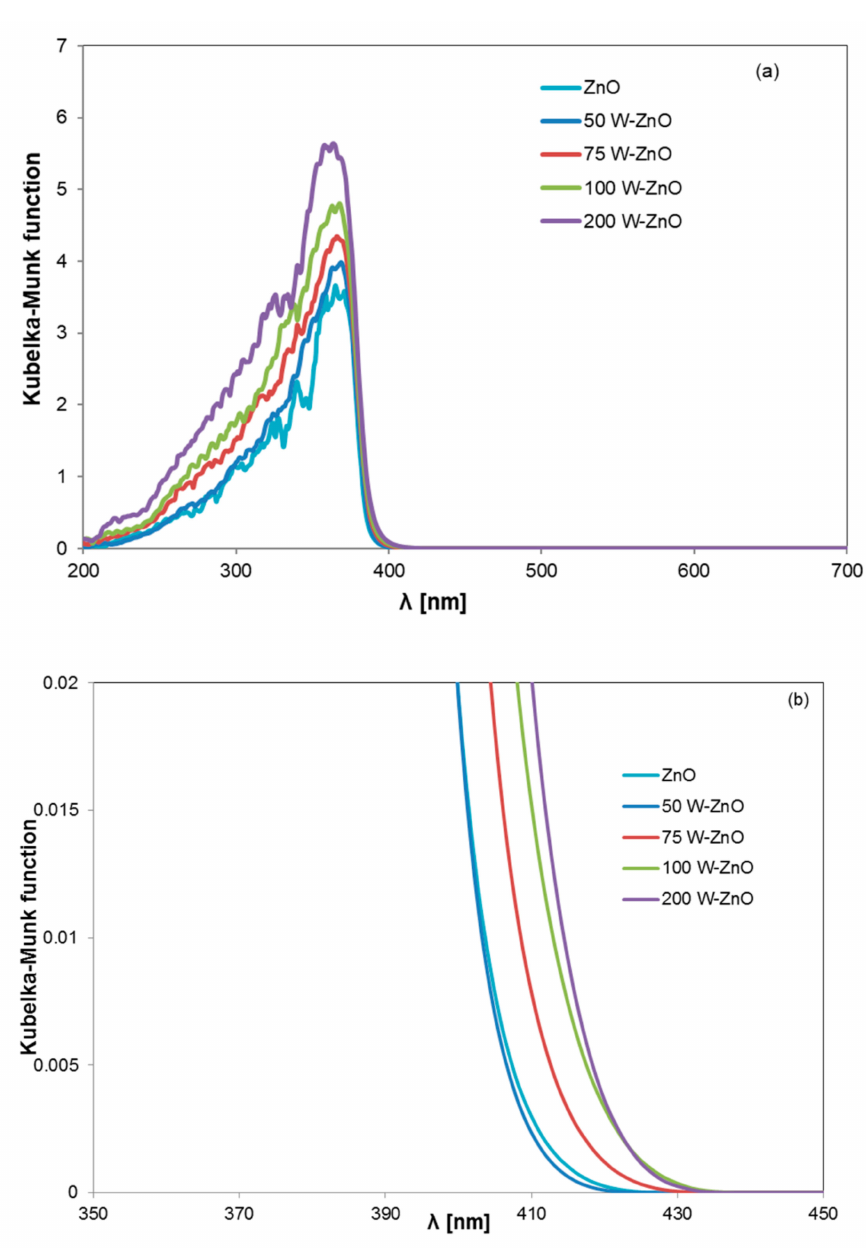
Figure 2. Kubelka-Munk function of ZnO and W-doped ZnO photocatalysts with different W contents in the range 200–700 nm ( a ) and in the range 350–450 nm ( b